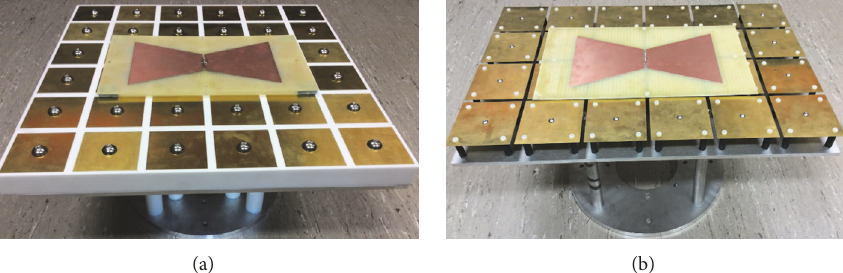
Figure 9: The fabricated prototype of low-profile bow tie antennas: (a) with dielectric-substrate HIS and (b) with substrate-less HIS.